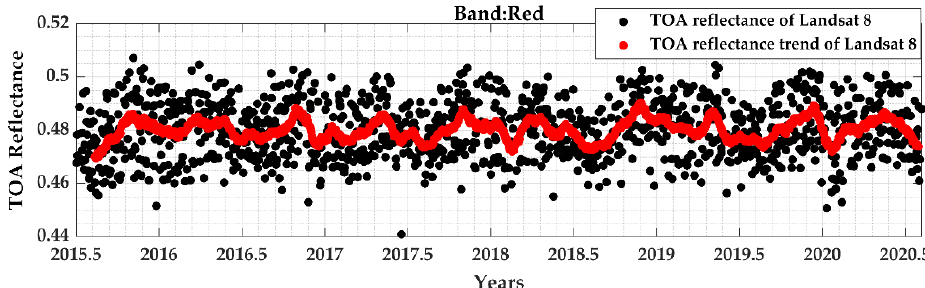
Figure 8. Landsat 8 trend with the daily acquisition (red dots represent the trend line detected by the Savitzky–Golay filter applied on the black dots, which is the BRDF-normalized TOA reflectance of Landsat 8).